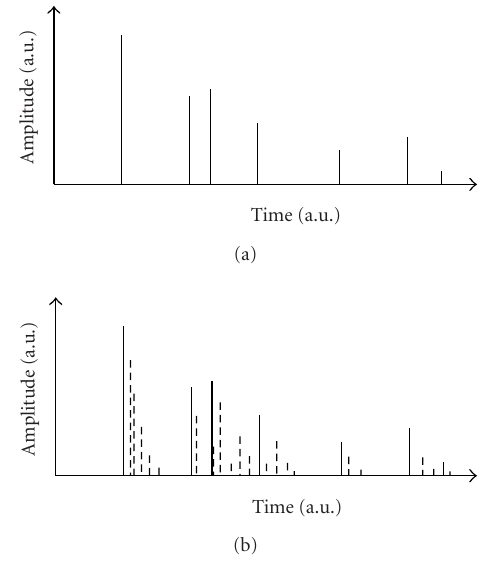
Figure 3: Visualization of an unfiltered impulse response for the image model and the SIBIC model. Notice that the first rays of each cluster are present in both models with the same amplitudes and time delays. However, the SIBIC model contains additional clusters, visually observed as the exponentially decreasing rays that follow the rays generated by the image model. (a) Image model. (b) Proposed model.